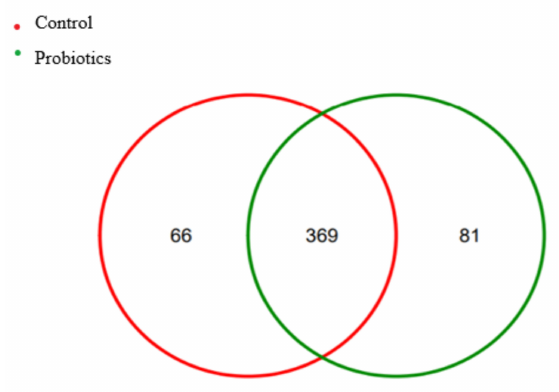
Figure 1. OTU Venn diagram.